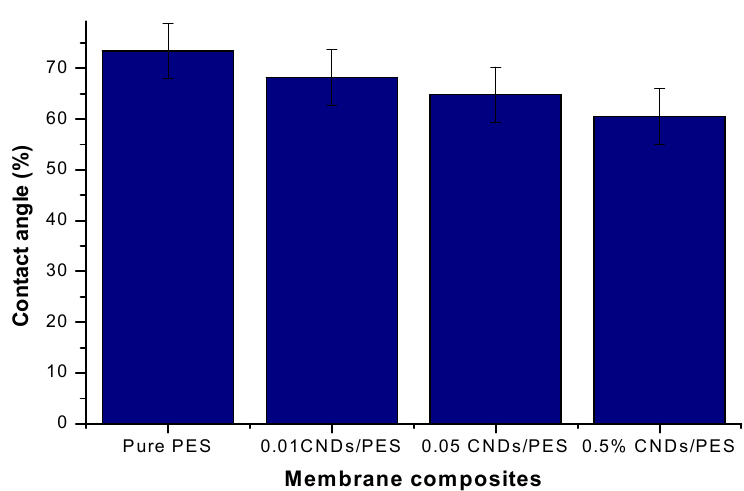
Figure 6. Characterization of the PES and CNDs/PES using Contact angle.